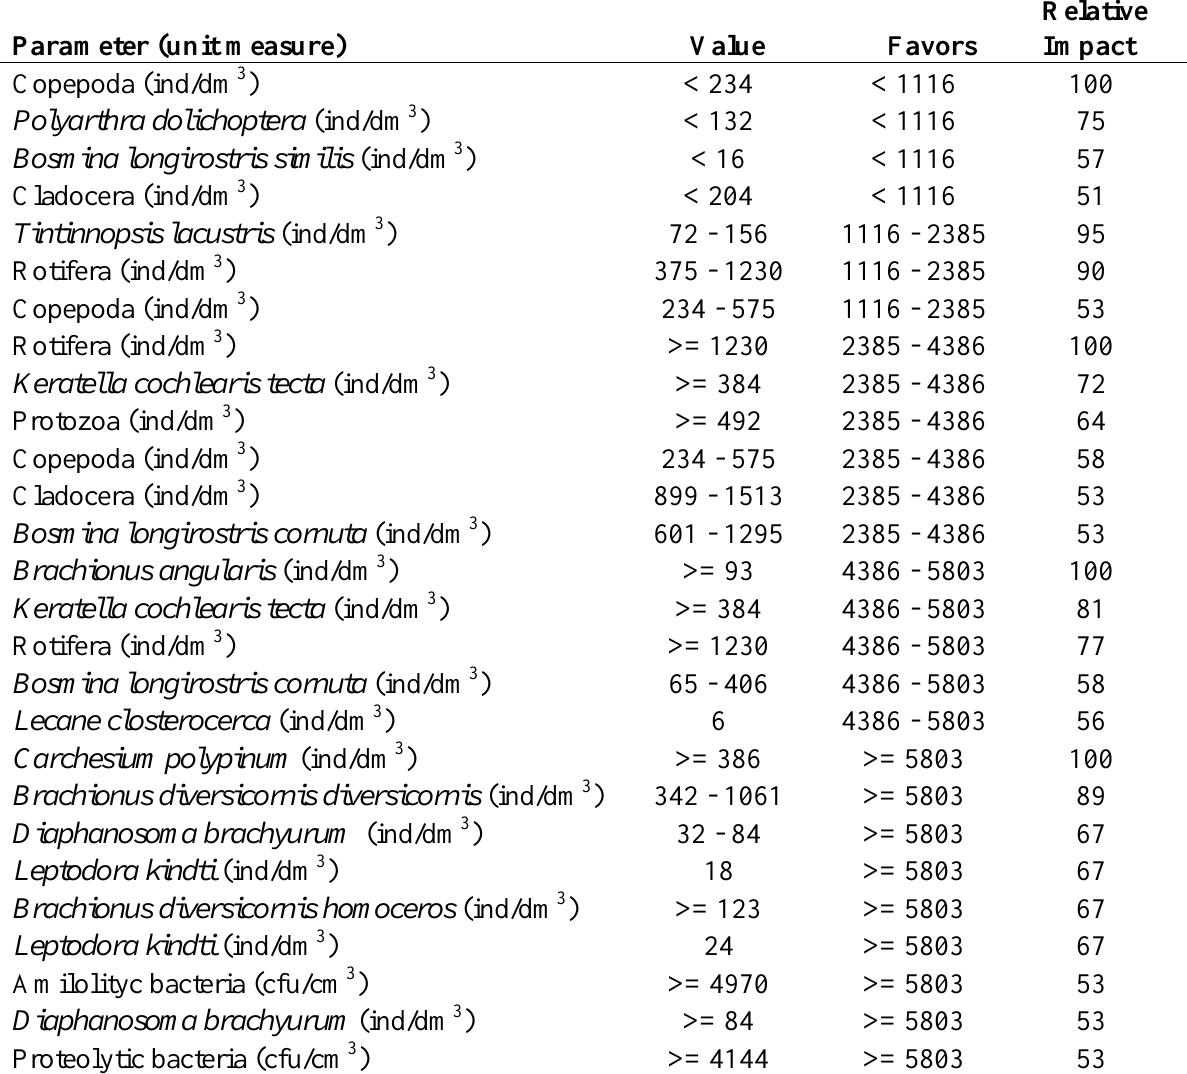
Table 3. Key Influencers Report and their impact over the values of total zooplankton (ind/dm 3 ) with zooplankton groups and species for the Gruža Reservoir.